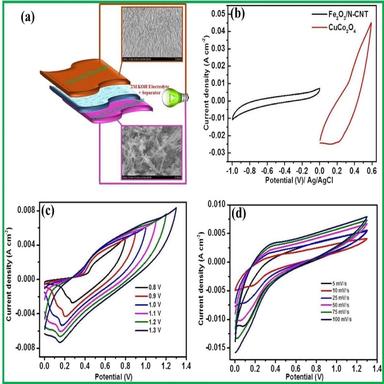
(a) Schematic representation of the assembled asymmetric supercapacitor device based on CuCo2O4 nanowires as a cathode material and Fe2O3/N-CNT as an anode material. (b) CV curve for optimized asymmetric device measured at different working potential windows at a scan rate of 50 mV s1 (c) CV curve for optimized asymmetric device measured at different scan rates (5e100 mV s1 ) in the potential range of 0 to þ1.3 V in aqueous solution of 2 M KOH.